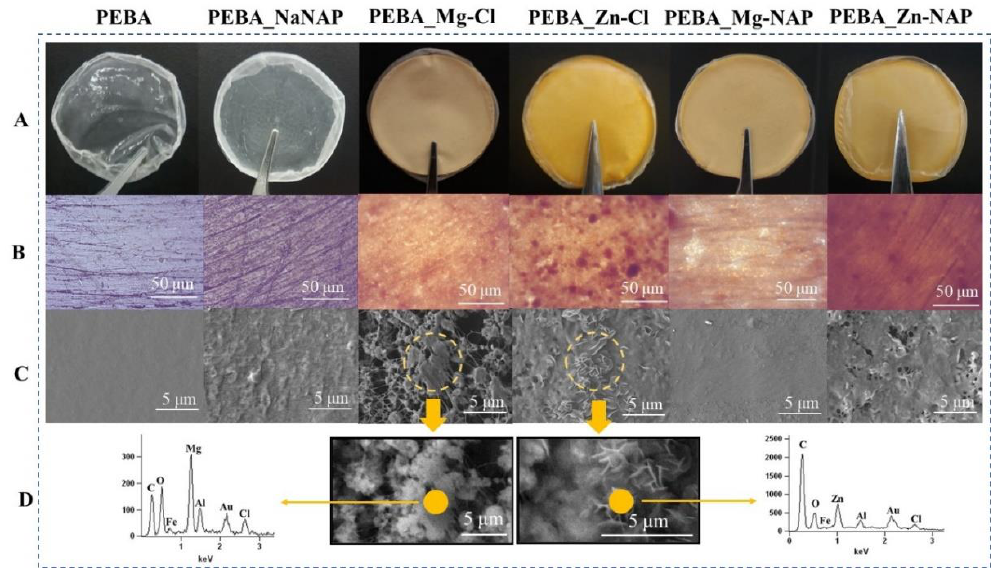
Figure 3. Samples are disposed in the columns. Line ( A ) macroscopic aspects, line ( B ) optical microscopy images, ( C ) SEM micrographs and ( D ) EDS spectra.